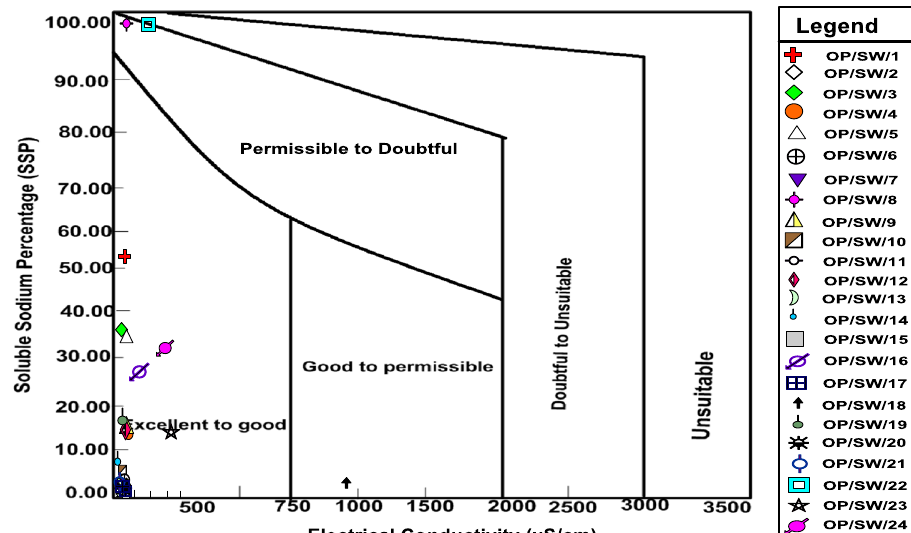
Fig. 3 Wilcox diagram of SSP classification for water sample of the study area (after